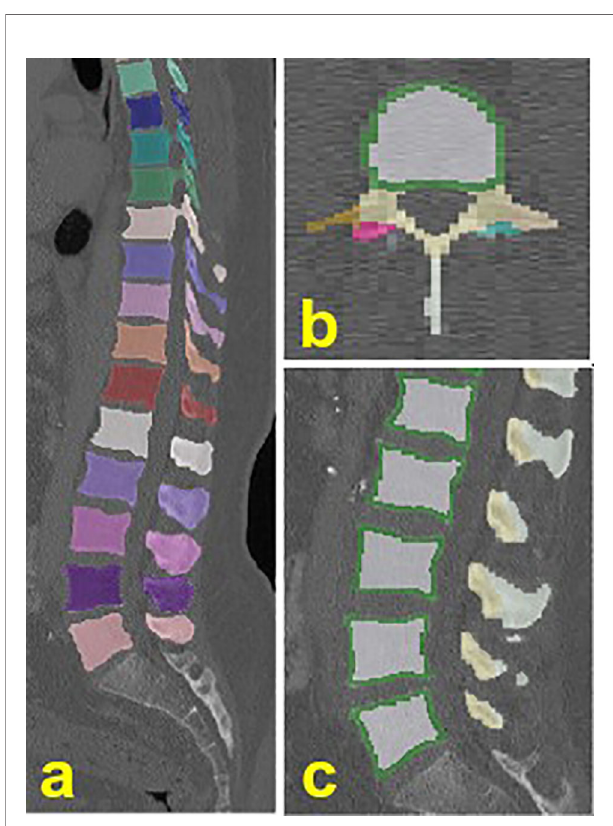
FIGURE 1 | Exemplary illustration of the automated labeling and segmentation. (A) individually labeled and segmented vertebrae from T4-L5. (B, C) vertebral subregions, including the trabecular (white) and cortical (green) compartment of the vertebral